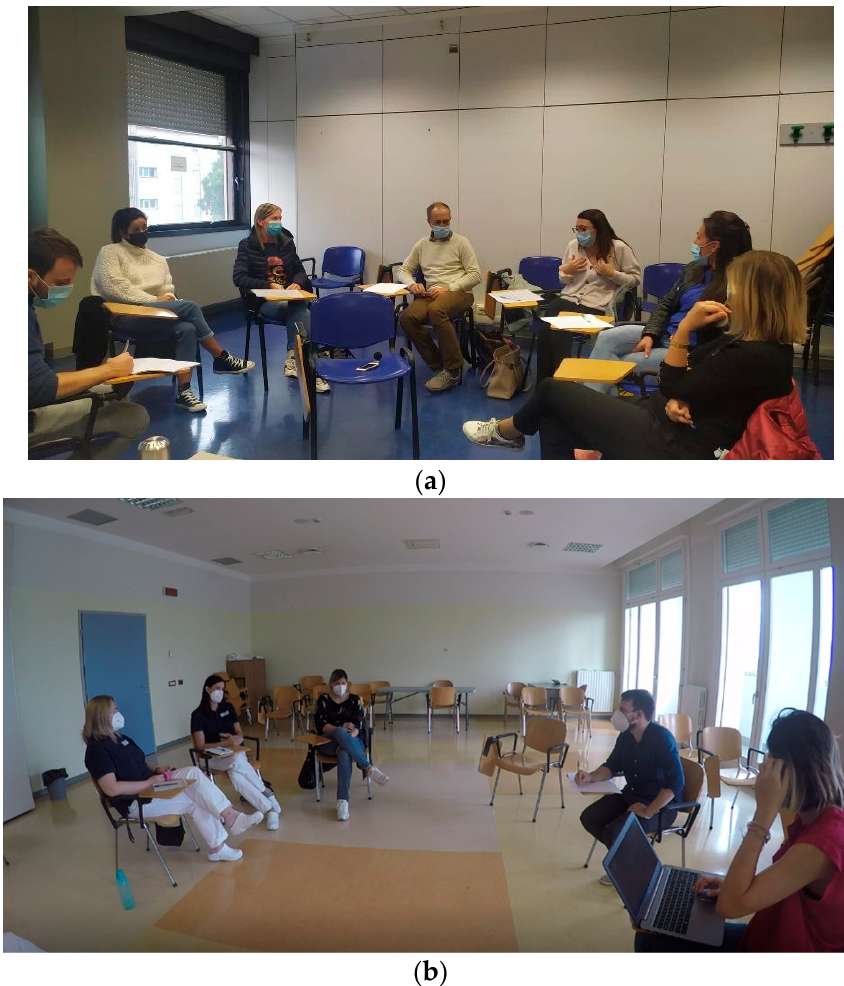
Figure 2. ( a ) Focus Group with nurses employed in a hospital. ( b ) Focus group conducted with a mixed group of nurses, SHO and physiotherapists at a retirement home.